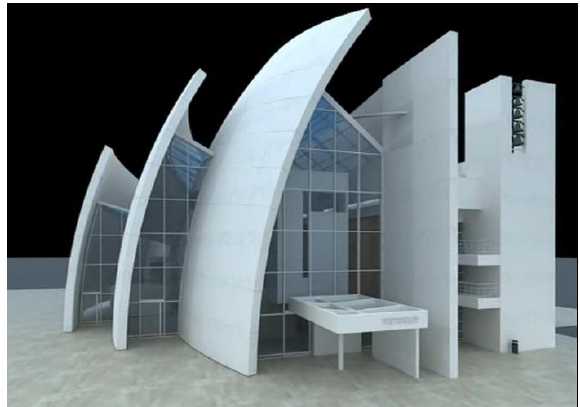
Figure 18. 3D Model of ‘Le Vele’ by Richard Meier in Tor Tre Teste (plot by T. Ortolani and S. Refi).